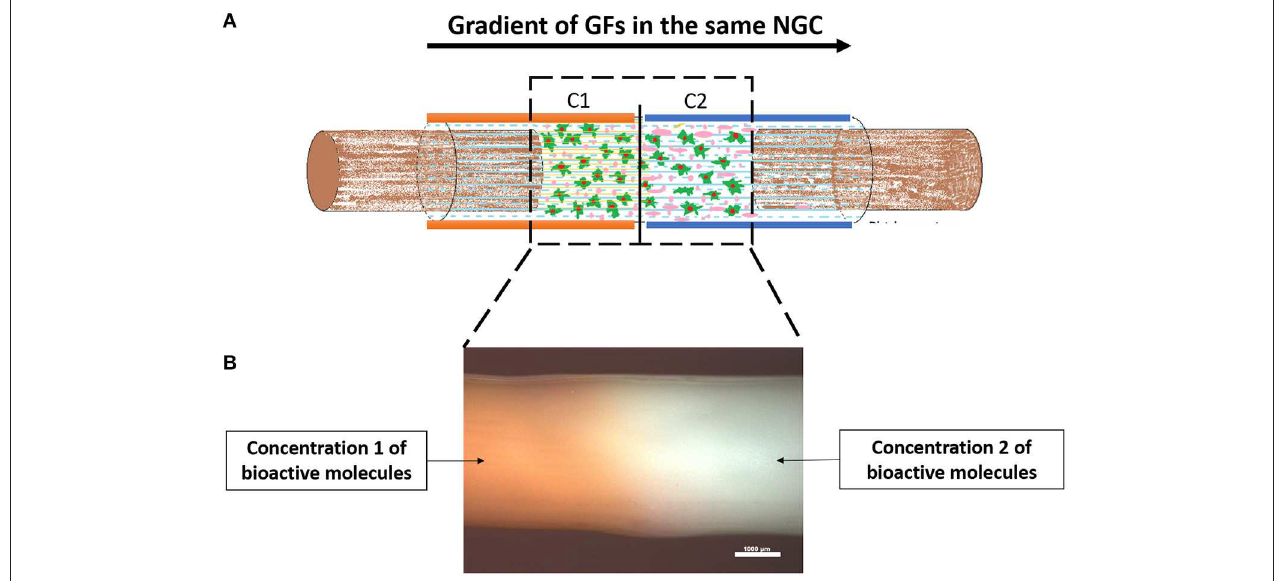
FIGURE 8 | Proof of concept regarding the fabrication of a silk fibroin NGCs incorporating a gradient of GFs. (A) Schematic of a NGC incorporating two different concentrations of GFs in the wall of the conduit. In principle, the gradient of GFs increases from proximal to the distal, therefore attracting the growing axons to reach their distal target. (B) Stereomicrograph of a silk fibroin NGC presenting a gradient along the walls. The orange color represents the chosen Concentration 1, followed by the white color, representing Concentration 2. As it can be assessed, there is no separation in the conduit between the different concentrations, as the conduit is totally uniform. Scale bar: 1,000 µ